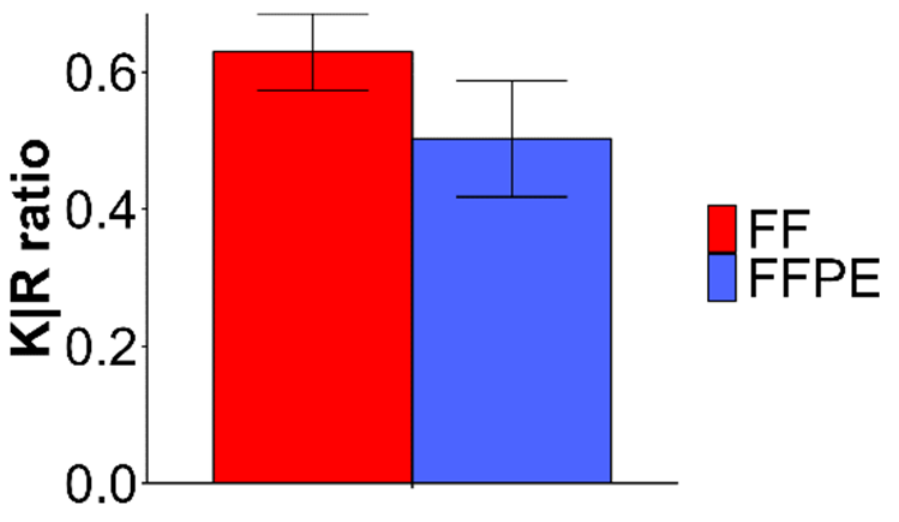
Figure 5. Ratio of C-terminal lysine-containing peptides versus C-terminal arginine-containing pep- tides (K/R) after samples processing with Buffer 2.